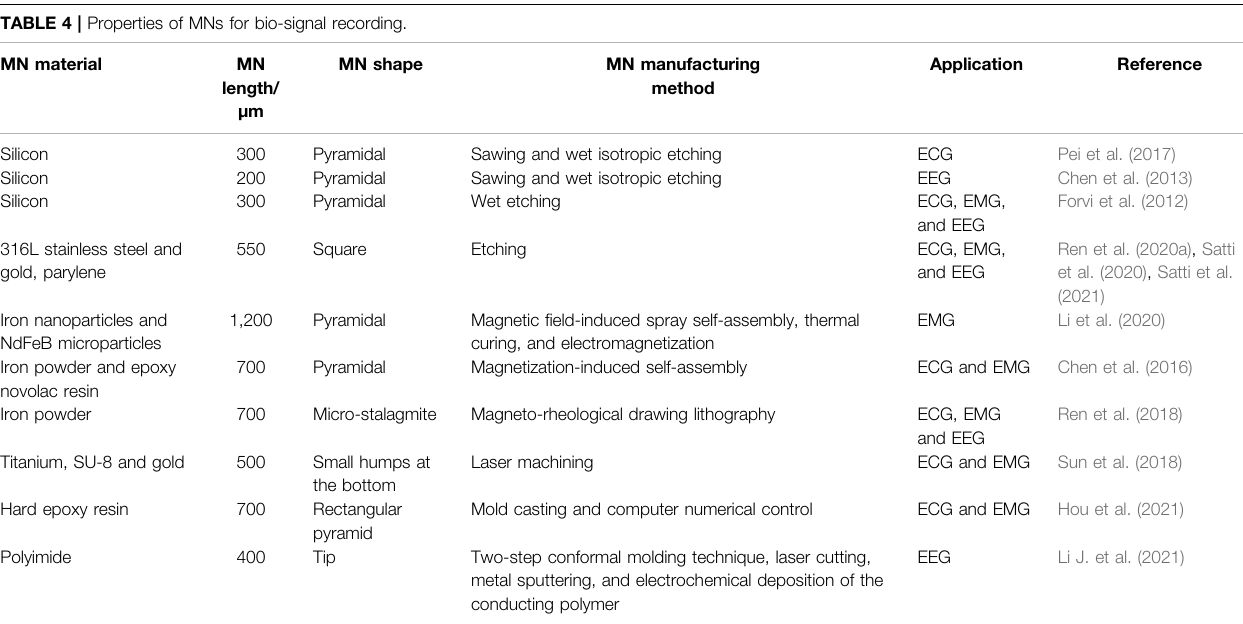
TABLE 4 | Properties of MNs for bio-signal